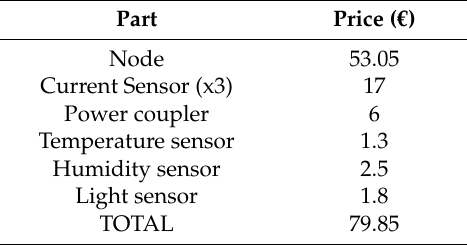
Table 2. Prototype cost.